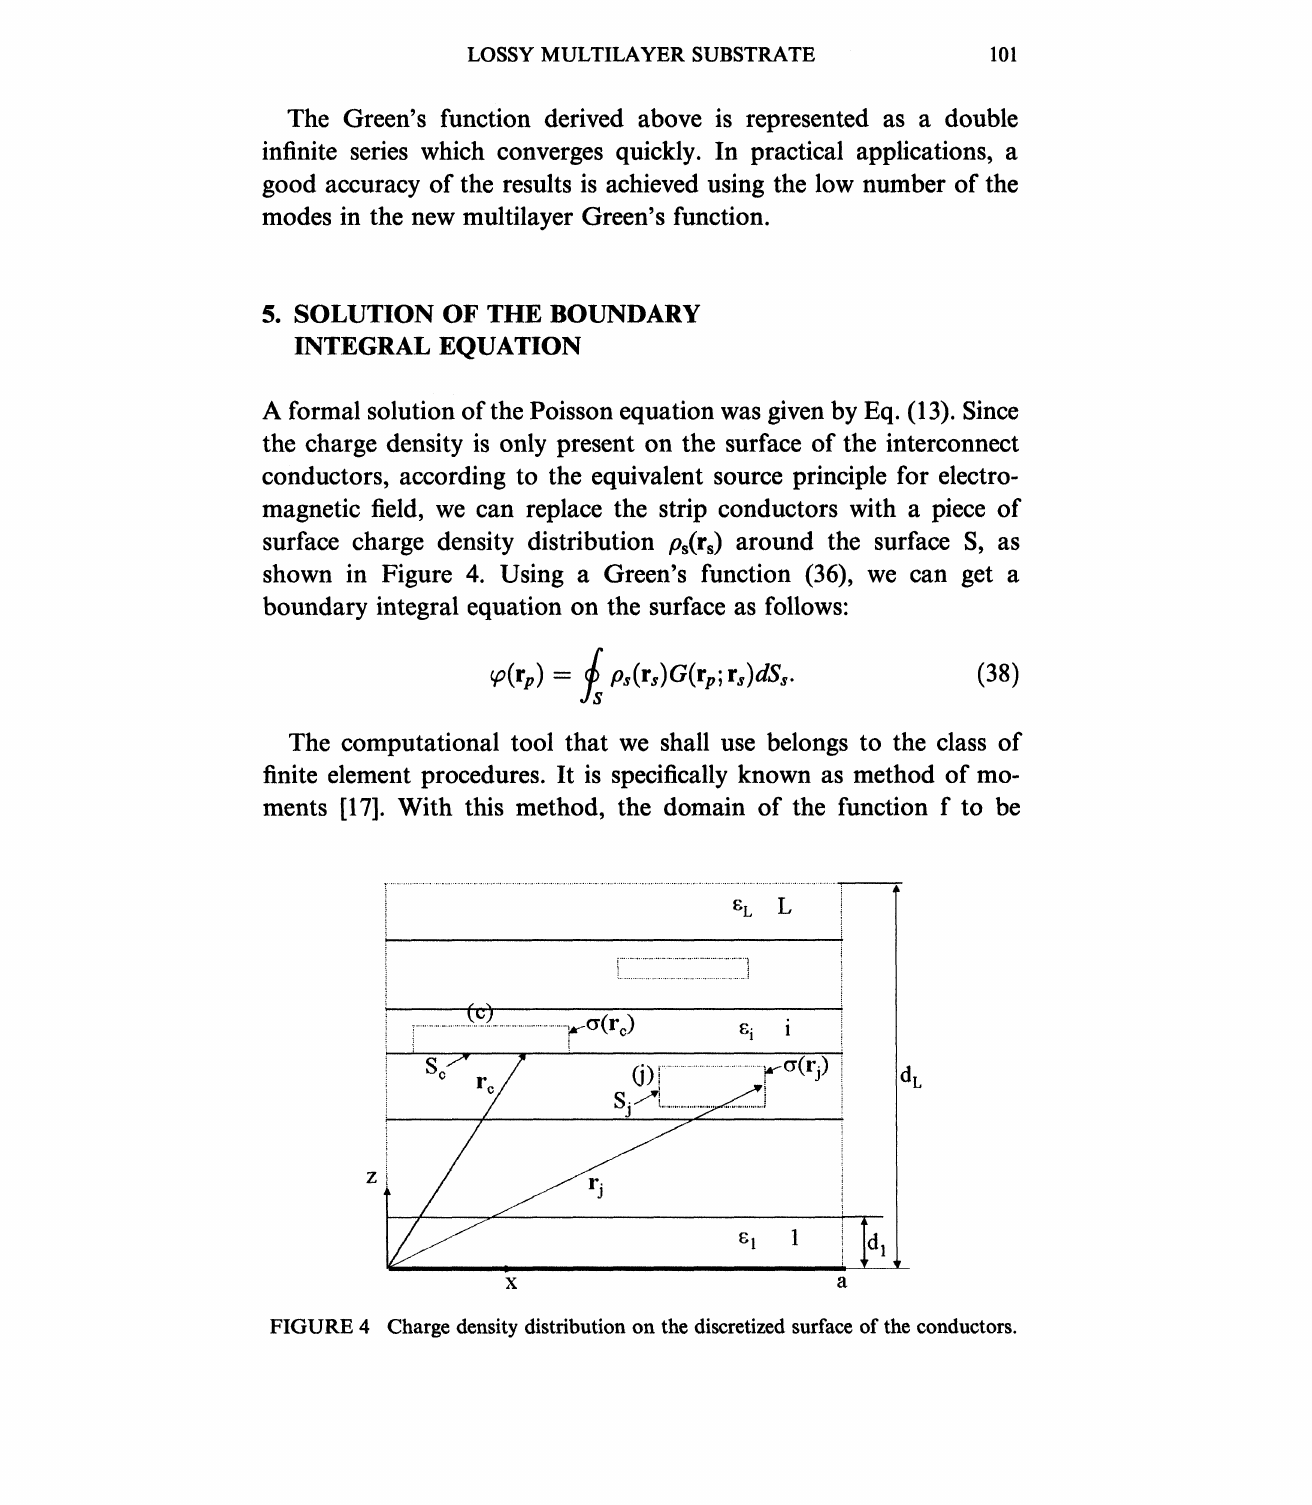
FIGURE 4 Charge density distribution on the discretized surface of the